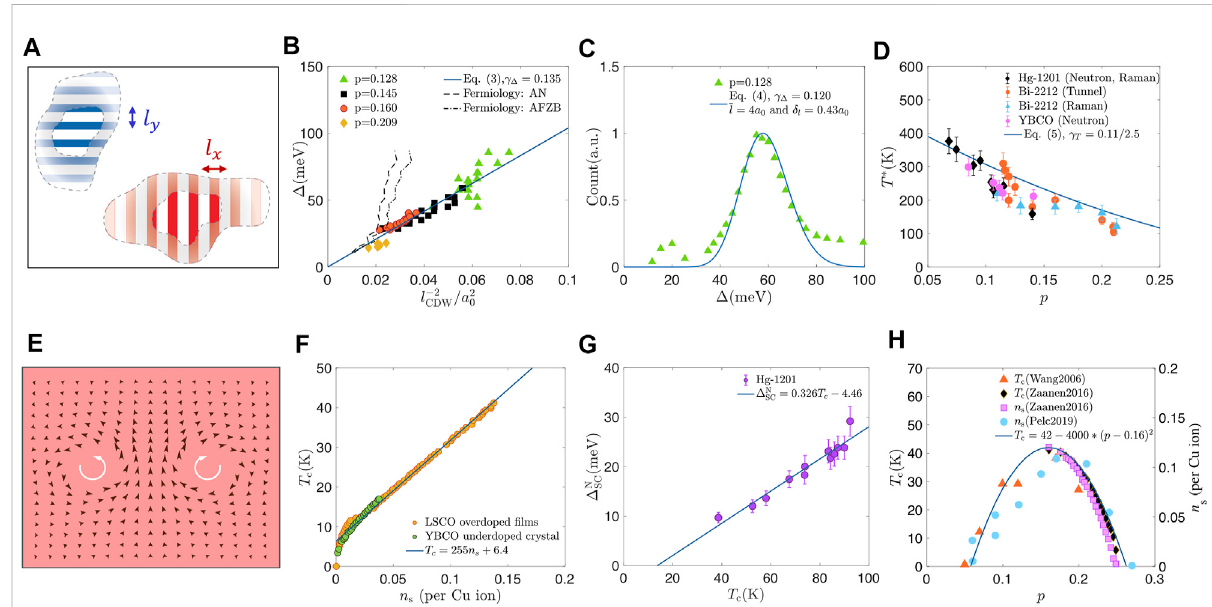
FIGURE 2 Universal spatial organizationofmesoscopic ordersandtheenergy-lengthscalingassociatedwithpseudogapphase. (A) Schematicdiagramof thelocallyunidirectionalCDWalong x -and y -axes[91]. (B) ScalingbetweenthespectralgapandtheCDWperiod.Symbolsaredatadeterminedfrom the low-temperature (6 K) phase of Pb-Bi2201 samples [42], and the solid line is a prediction of Eq. 3. (C) Distributions of the spectral gap within the Pb-Bi2201 samples.SymbolsareSTMdatafromRef.[42],andthesolidlineisapredictionfromEq.4. (D) Dopingdependenceofthepseudogap onsettemperature T *.Thesymbolsrepresentexperimentaldata,andthesolidlineisapredictionfromEq.5. (E) Unbindingofvortex-antivortexpairs, representing a spatial organization of the phase fl uctuations. (F) The dependence of T c on super fl uidity at zero temperature [69]. (G) The linear dependence of the nodal superconducting gap Δ N SC on T c . The data are determined from Ref. [11]. (H) The dome doping dependence of T c and n s . Symbols are experimental data determined from [92 – 94]. (B) and (D) are adapted from Ref. [65], and (A) and (F) are adapted from Refs. [69, 91] with